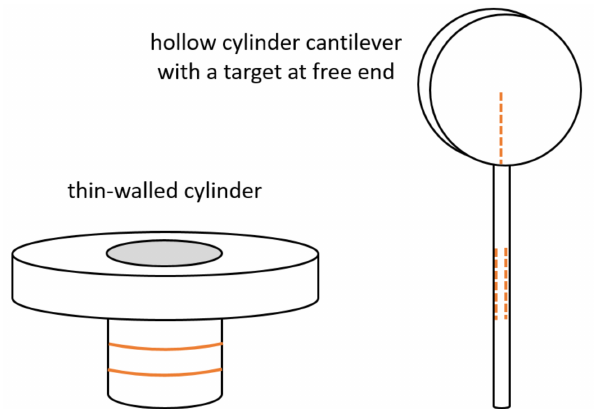
Figure 13. Diagram demonstrating the geometry of an FOS described in [76]. Solid orange line denotes an optical fibre on the outside; dashed orange line denotes an optical fibre on the